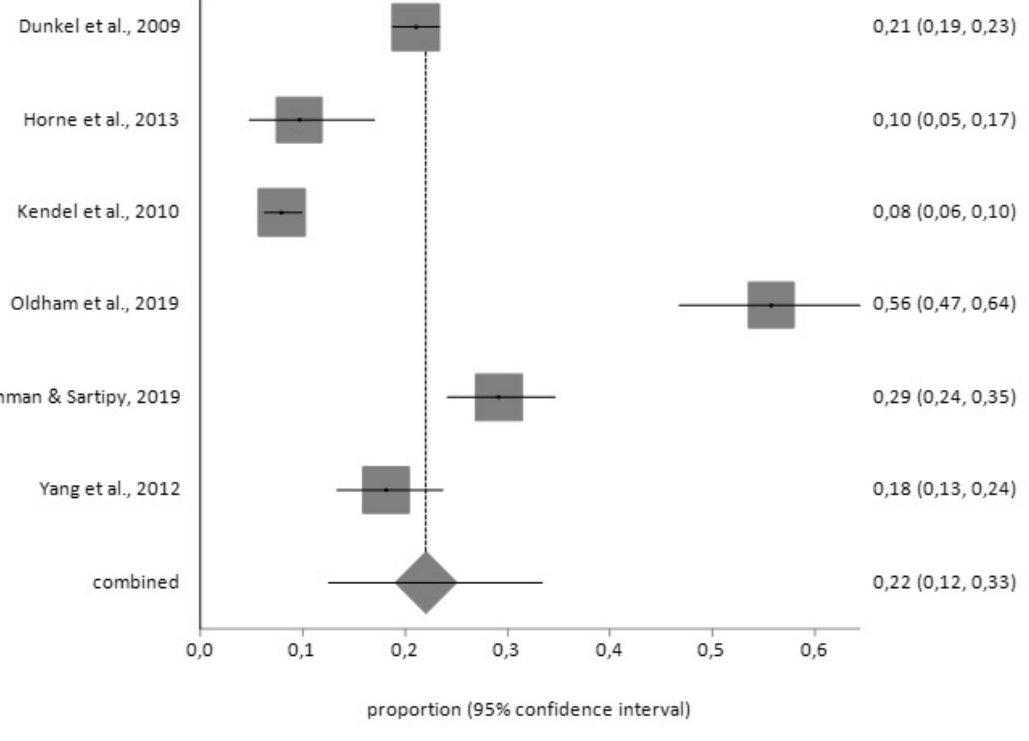
Figure 6. Forest plot for pre-CABG depression using Patient Health Questionnaire (PHQ-9).